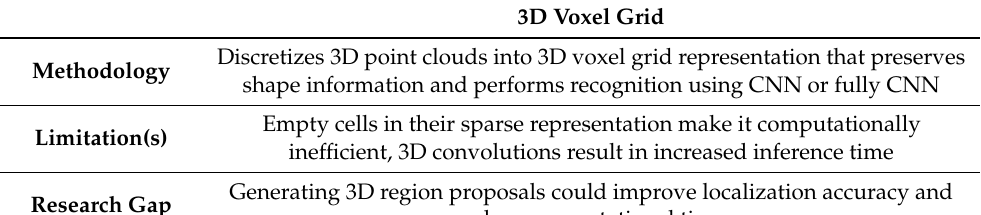
Table 12. Methodology and Limitation(s): 3D Voxel Grid-based 3DOR Methods.